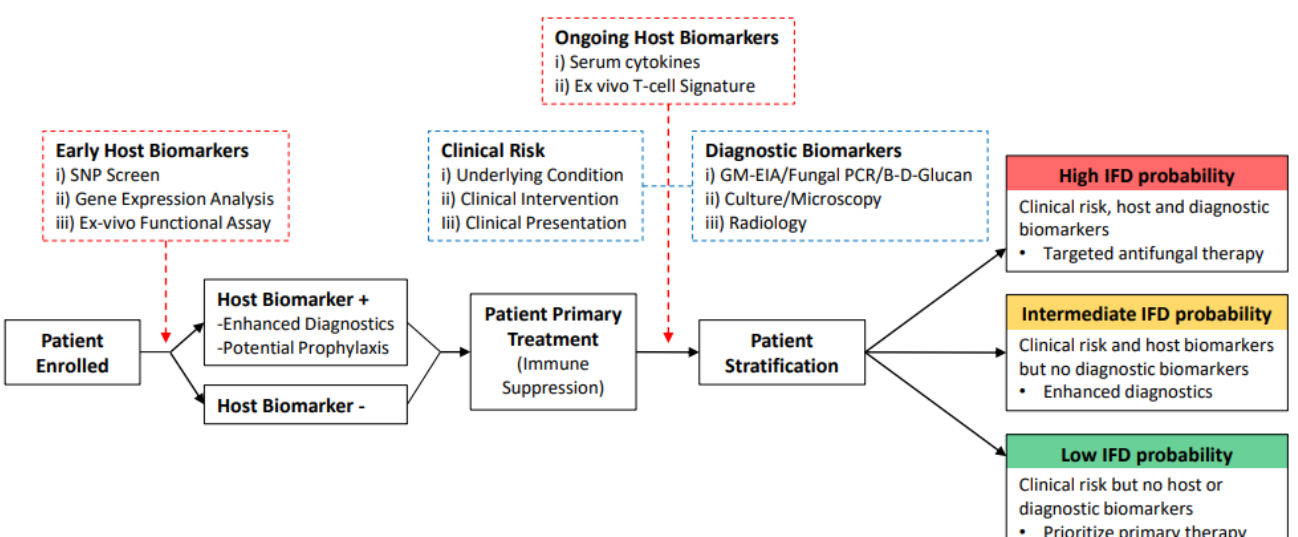
Figure 1. Incorporating host biomarkers into IFD diagnostic strategies. Prospective IFD diagnostic strategy that utilizes the latest advancements in IFD-associated host biomarkers alongside conven- tional fungal biomarkers and clinical risk to better target anti-fungal prophylaxis [65,85,90,96–98]. Blue dotted boxes represent current investigations into IFD susceptibility and incidence. Red dotted boxes represent potential new host biomarker investigations into IFD susceptibility and incidence. Solid boxes represent patient pathway and potential stratification into high, intermediate, and low IFD risk cohorts.